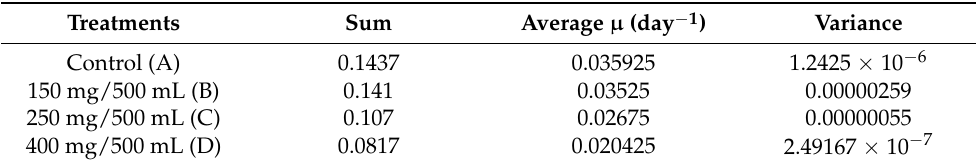
Table 2. Analysis of variance (ANOVA) of F and p values between experiments.